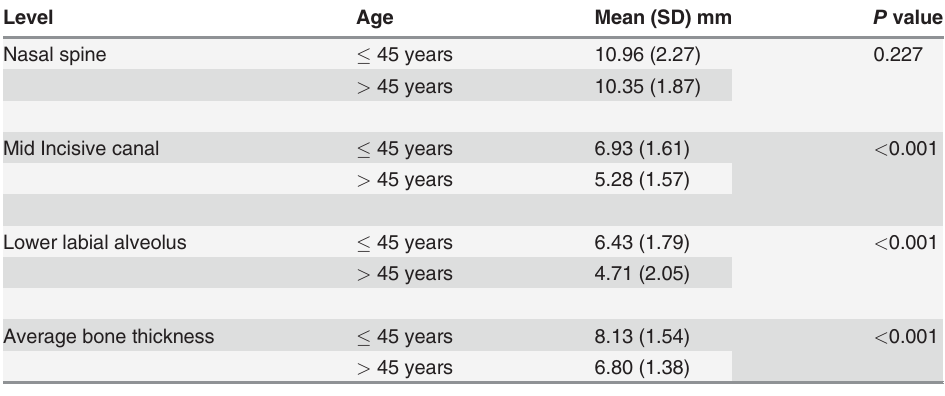
Table 5. Differences in average anterior maxillary bone thickness between those aged above and below 45